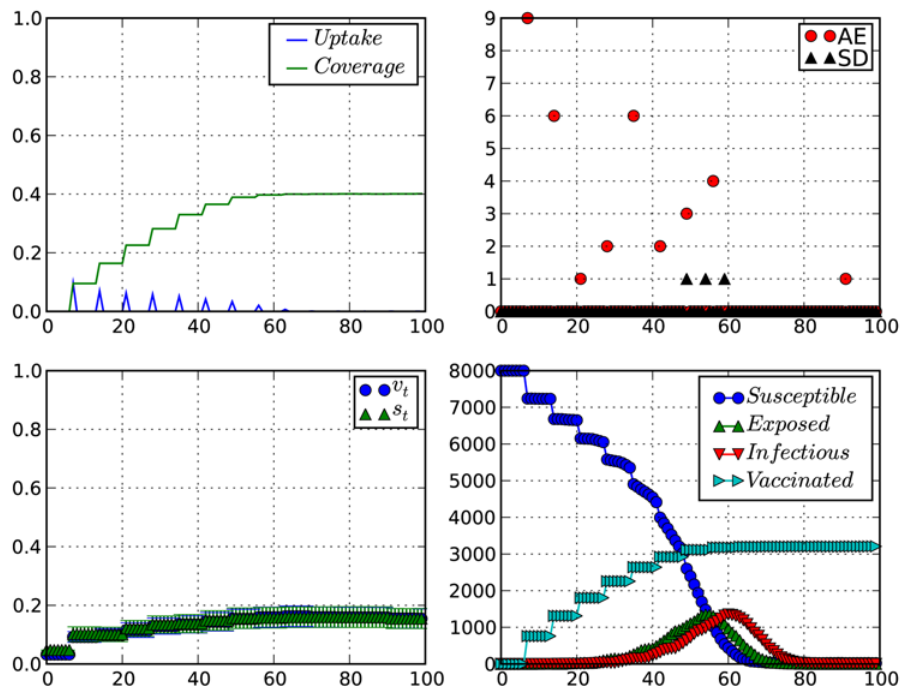
Figure 2. Impact of occurrence of adverse vaccination events at the beginning of a vaccination campaign. Top-left: vaccination coverage and vaccine uptake ( 6 8000 doses);top-right: adverse vaccination and serious disease events; Bottom-left: willingness to vaccinate ( v t ) and perceived vaccine safety ( s t ); Bottom-right: Epidemiological time-series. Time is in weeks. p ae ~ 0 : 01 ; p sd ~ 0 : 001 .